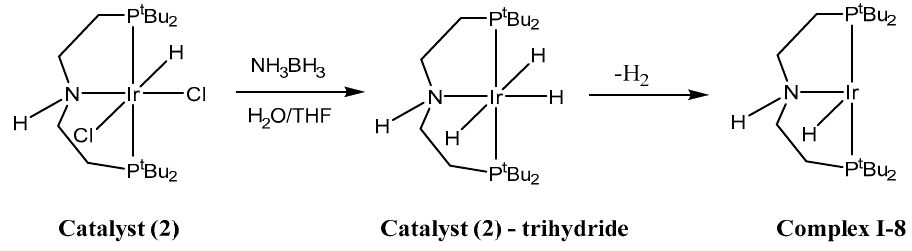
Figure 6. Formation of the coordinatively unsaturated complex I-8 which is capable of releasing H 2 from ammonia borane.